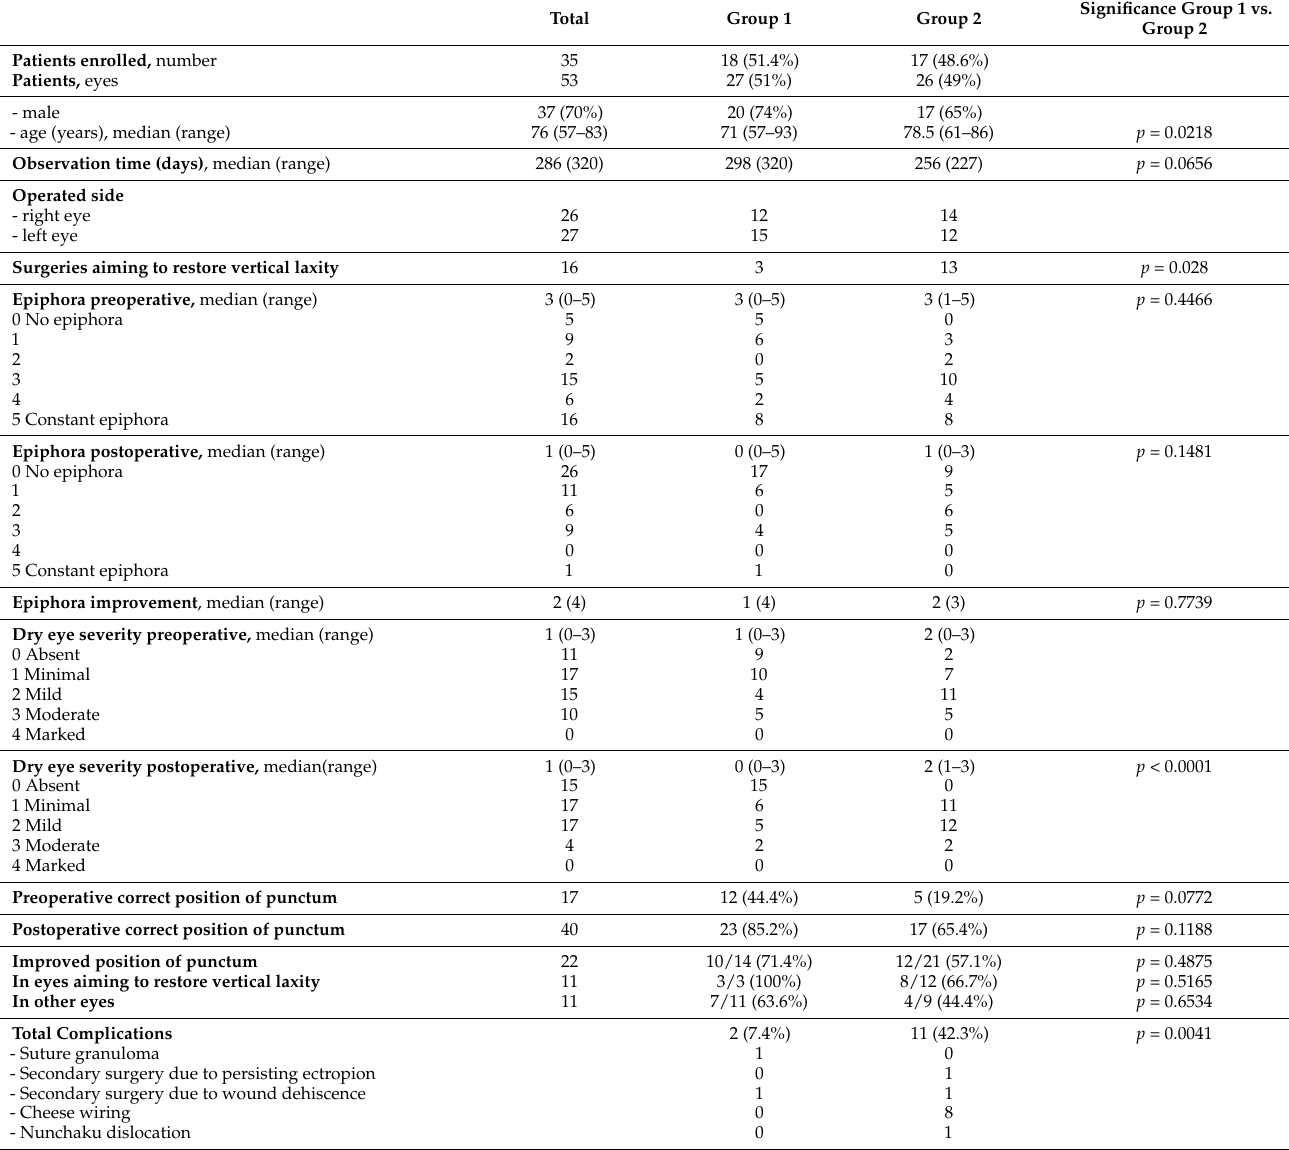
Table 1. Patients’ characteristics, pre- and postoperative findings. Epiphora was assessed with the Munk Scale (0: No epiphora; 1: Epiphora requiring dabbing less than twice per day; 2: